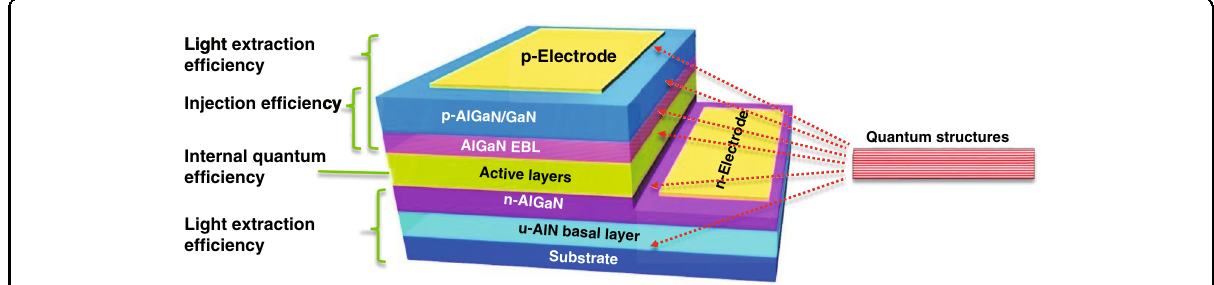
Fig. 1 Schematic of an AlGaN DUV LED structure. Relative layers are contributed to the main ef fi ciency parameters including the injection, internal quantum, and extraction ef fi ciencies. The AlGaN quantum structures have been implanted into heterostructural epilayers for the ef fi ciency